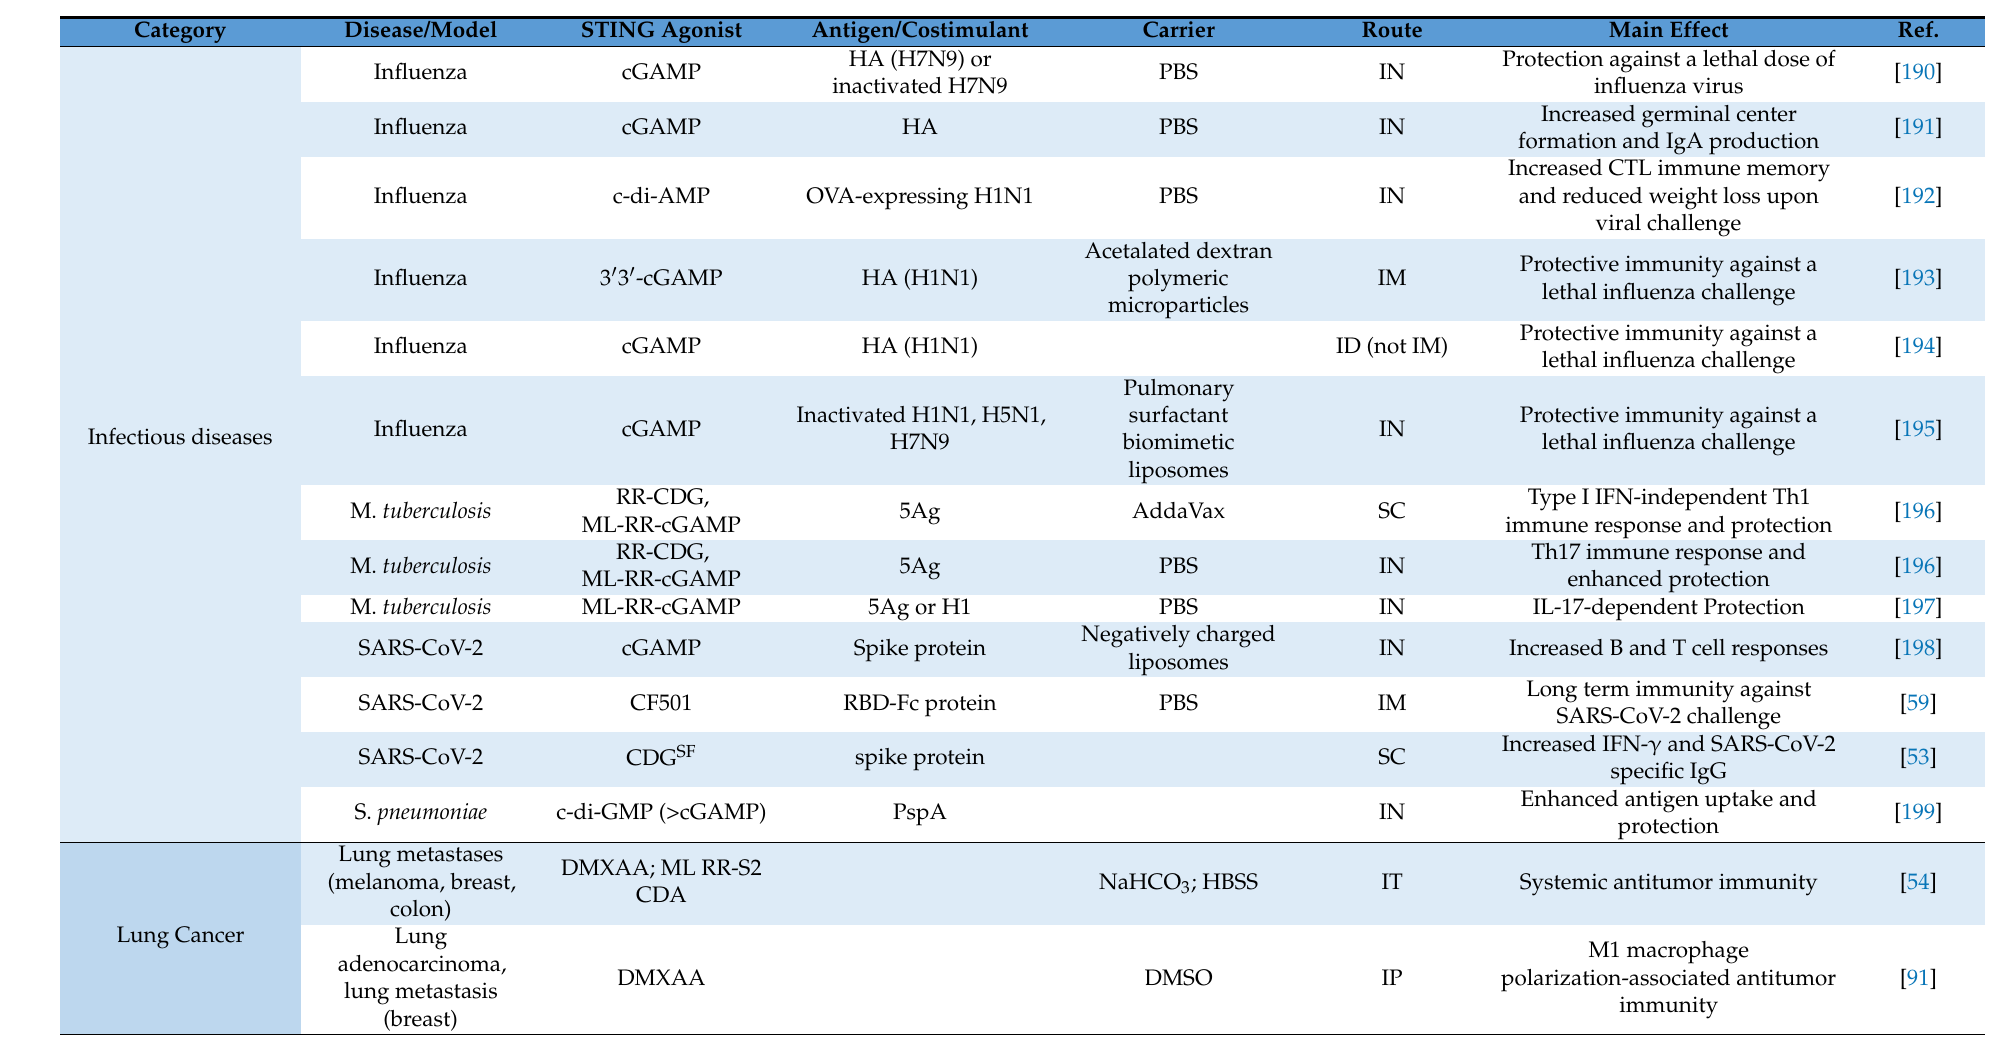
Table 3. Lung vaccines incorporating STING